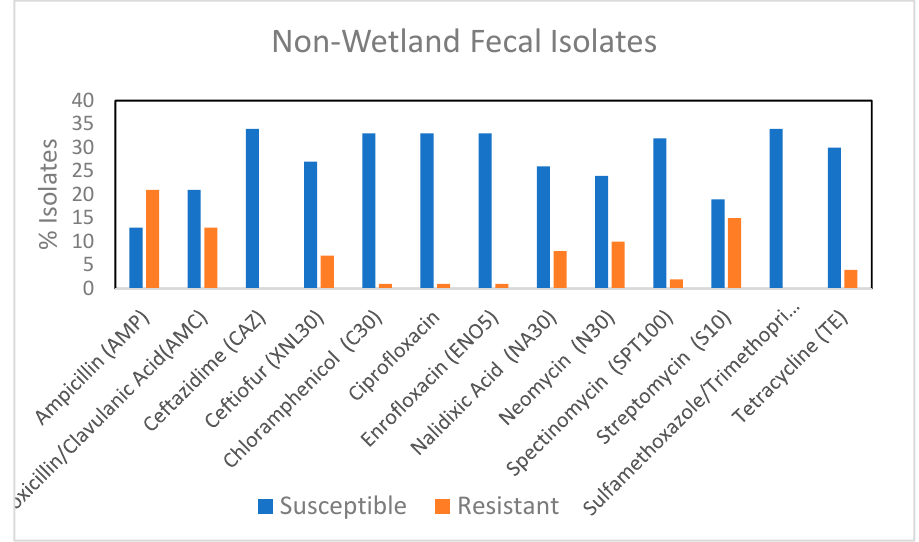
Figure 3. Percentage of fecal E. coli isolates from non-wetland (n = 34) showing resistance and susceptibility to 13 selected antimicrobials. AMC, amoxicillin/clavulanic acid; AMP, ampicillin; XNL, ceftiofur; C, chloramphenicol; CAZ, Ceftazidime CIP, ciprofloxacin; ENO, Enrofloxacin NA, Nalidixic acid, N, Neomycin, STR, streptomycin; SPT, spectinomycin, TE, tetracycline; SXT, trimethoprim/sulfamethoxazole.